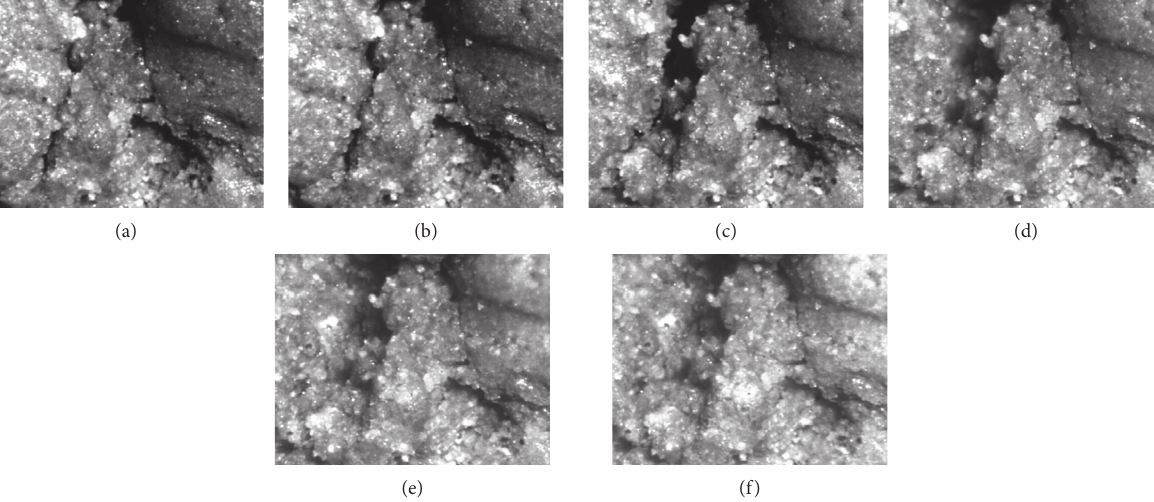
Figure 15: The continuous images under different tensile displacements in Zone 2: (a) L � 0.010 mm; (b) L � 0.035 mm; (c) L � 0.080 mm; (d) L � 0.110 mm; (e) L � 0.125 mm; (f) L � 0.140